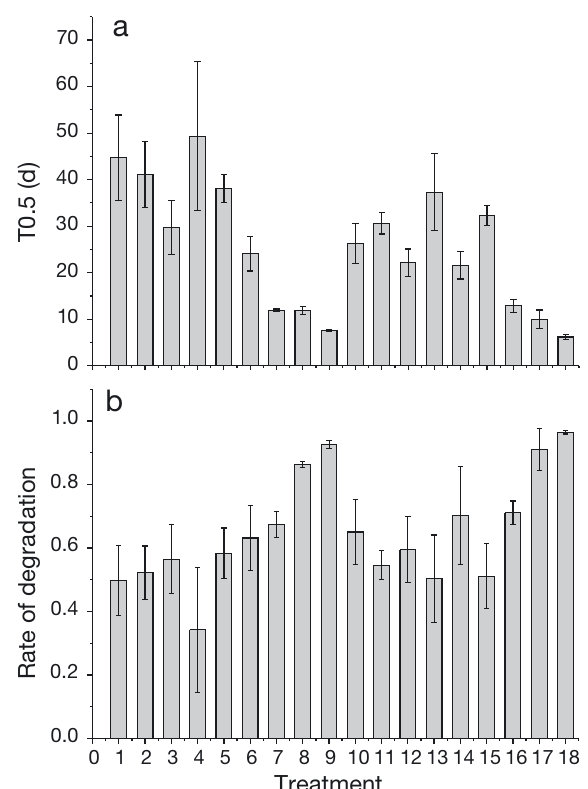
Fig. 2. (a) The half-life (T0.5) and (b) elimination rate of metho myl according to treatment. See Table 1 for treatment details